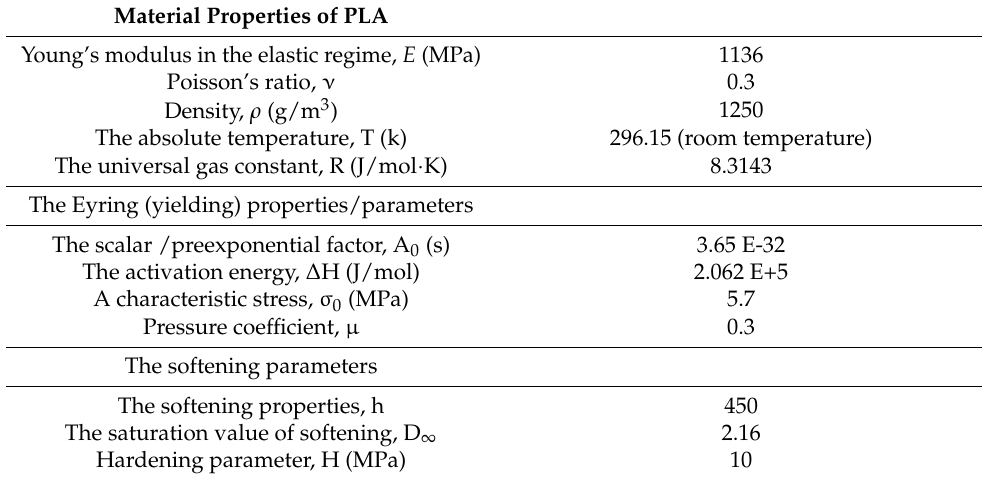
Table 3. Material properties of PLA used in numerical analyses